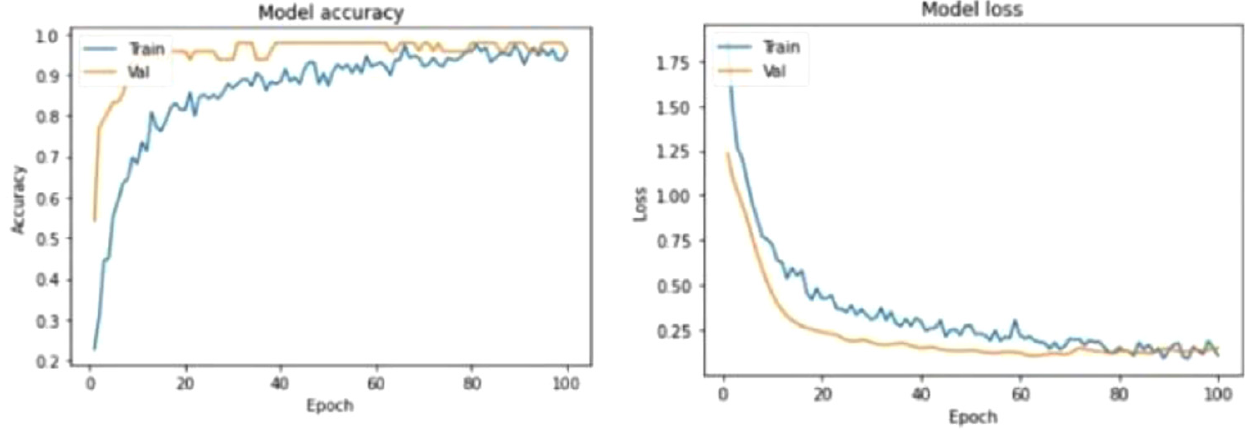
Figure 5. Learning Curves. The figure depicts the learning curves for Model Accuracy and Model Loss where each graph has a curve for Training and Validation performances.